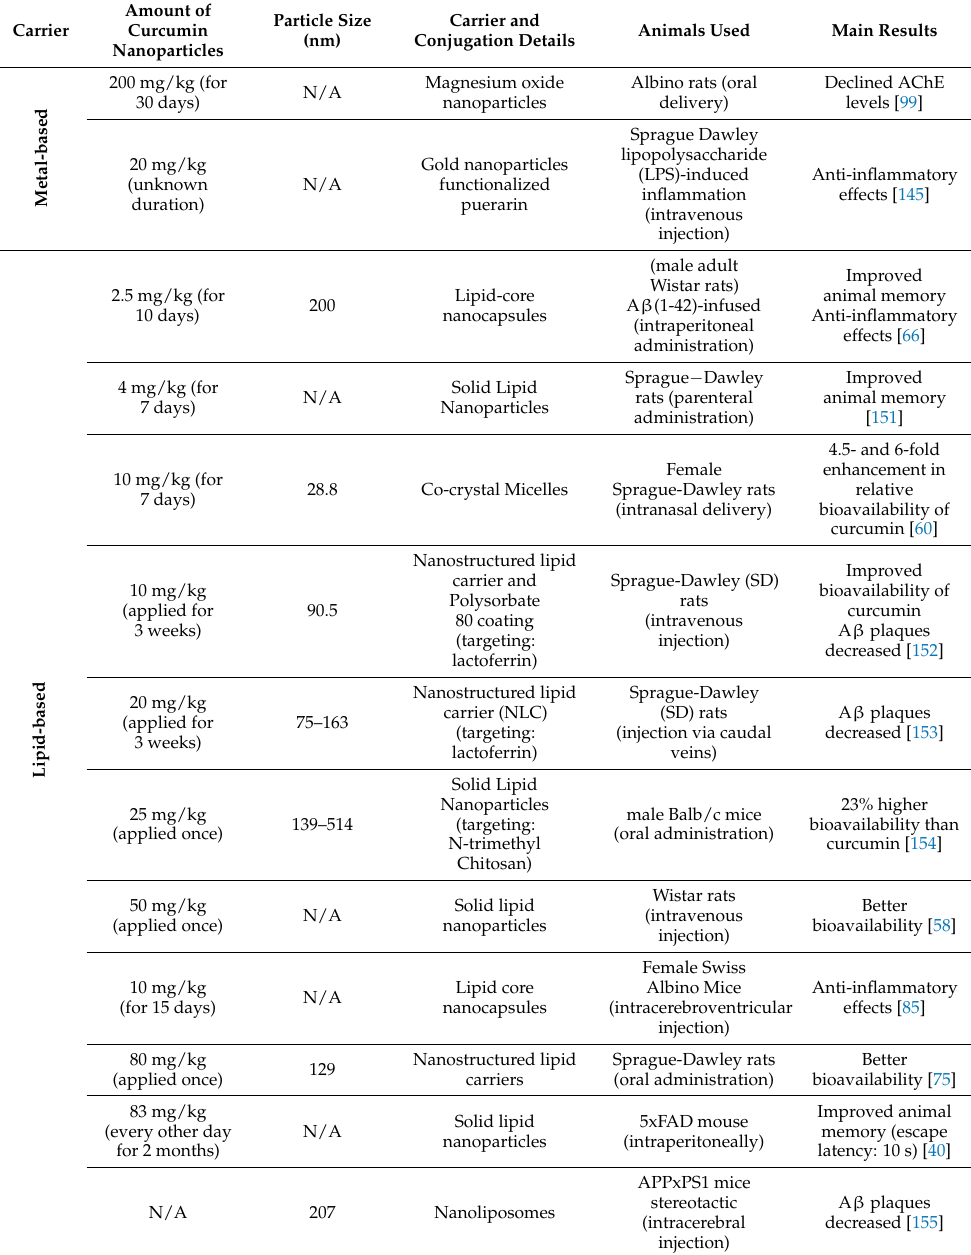
Table 1. In vivo studies involving a carrier and targeting agent for the delivery of curcumin for the treatment of